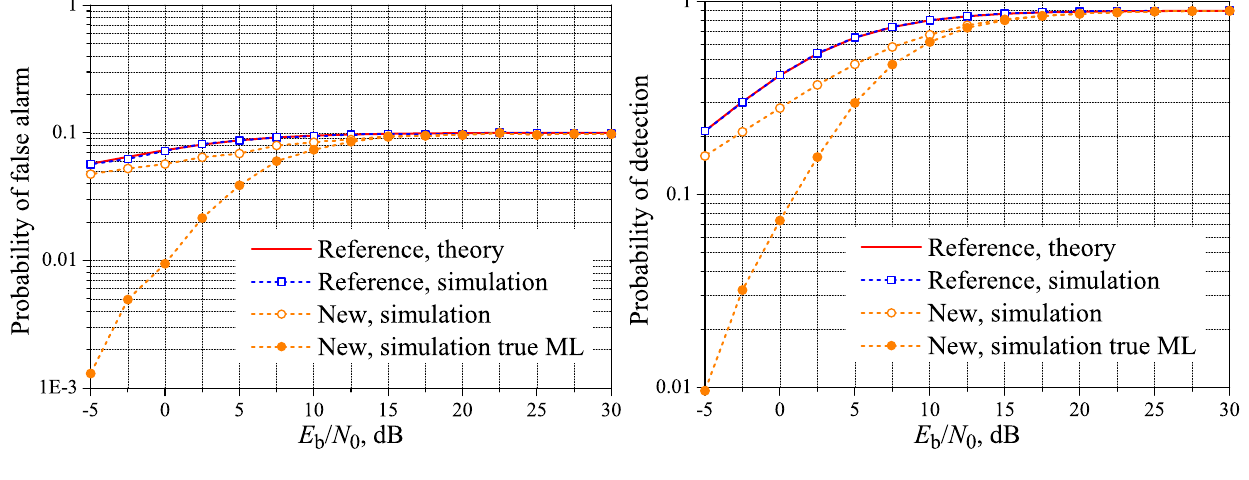
Figure 10. Spectrum sensing performance for the complex-valued Rayleigh reporting channel. M = 5 and K = 1 ( top ); K = 3 ( middle ); and K = 5 ( bottom ).